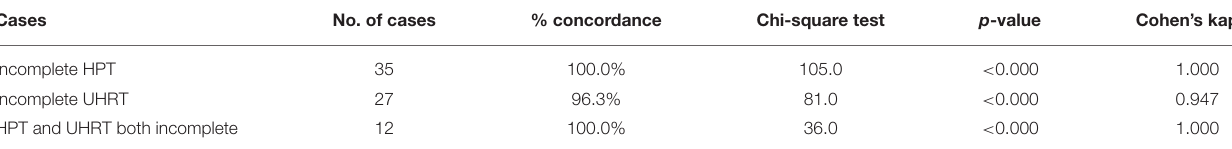
TABLE 2 | Concordance between complete diagnostic protocol (CDP) and upright BPPV protocol (UBP) with positive incomplete outcomes of head pitch test (HPT) and upright head roll test (UHRT).